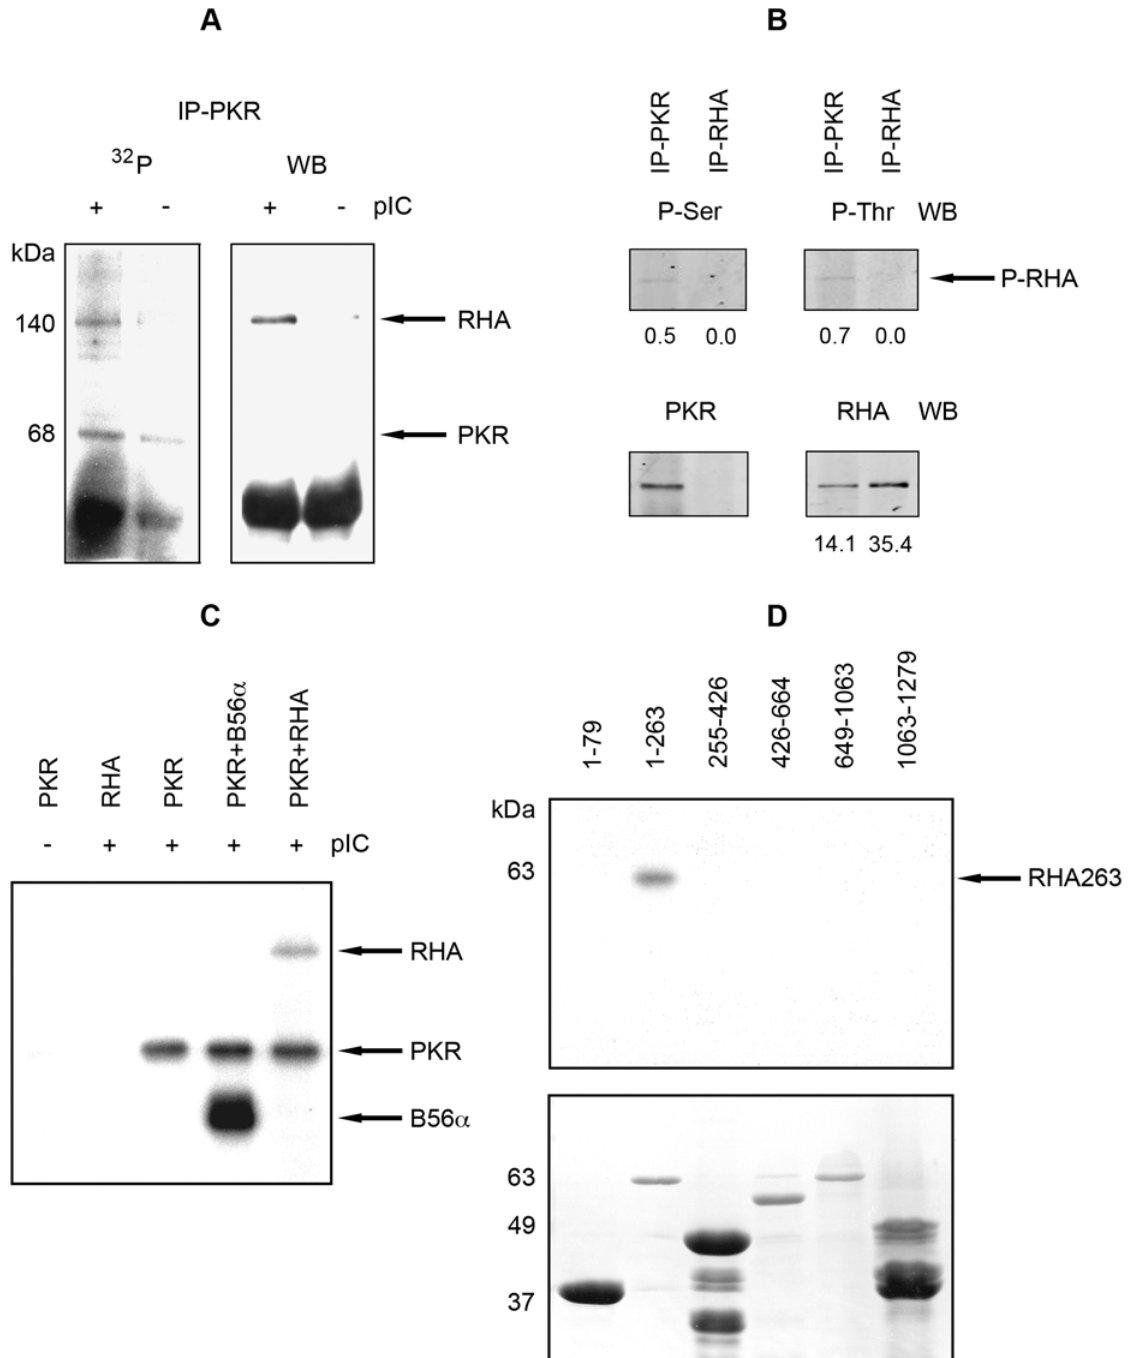
Figure 3. RHA is a substrate for PKR. (A) An autoradiograph (32P; on the left) and Western blot (WB; on the right) showing electrophoretically separated proteins labeled with 32 P by PKR in a kinase assay, or probed with a rabbit anti-RHA antibody, respectively. Proteins were immunoprecipitated with mouse anti-PKR (IP-PKR) from MEFs expressing human PKR either untreated ( 2 ) or treated ( + ) with pIC. (B) A Western blot showing electrophoretically separated proteins immunoprecipitated from HeLa cells with anti-PKR (IP-PKR) or anti-RHA (IP-RHA) antibodies, then probed with anti-phosphoserine (P-Ser) and anti-phosphothreonine (P-Thr). Arrows indicate phosphorylated RHA (P-RHA). Blots were stripped and re- probed with anti-RHA, or anti-PKR antibodies. Primary antibodies were detected using fluorescent-labeled secondary antibodies. The intensity of the immune-positive bands from the blot was quantitated, and these values are given at the bottom of each panel as relative arbitrary units. (C) An autoradiograph of electrophoretically separated proteins labeled with 32 P by PKR in an in vitro kinase assay. Arrows indicate autophosphorylated PKR and phosphorylated RHA, and, as a control, the previously established PKR substrate B56 a . PKR activity is induced by treatment with pIC, indicated at the top of the figure ( 2 / + ). (D) An autoradiograph of GSTRHA peptides 32 P-labeled by PKR in a kinase assay and electrophoretically separated by SDS- PAGE gel (upper panel). Amino acid end points for each RHA construct are indicated over each lane. The arrow indicates the phosphorylated RHA peptide (RHA263). The lower panel shows the Coomassie-stained, SDS-PAGE gel assayed above.